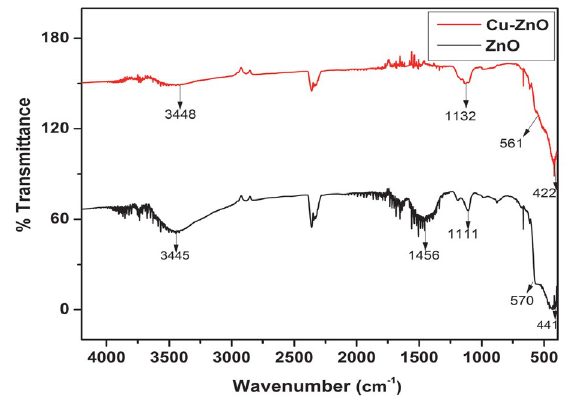
Figure 3. FT-IR data of ZnO and Cu-ZnO NPs